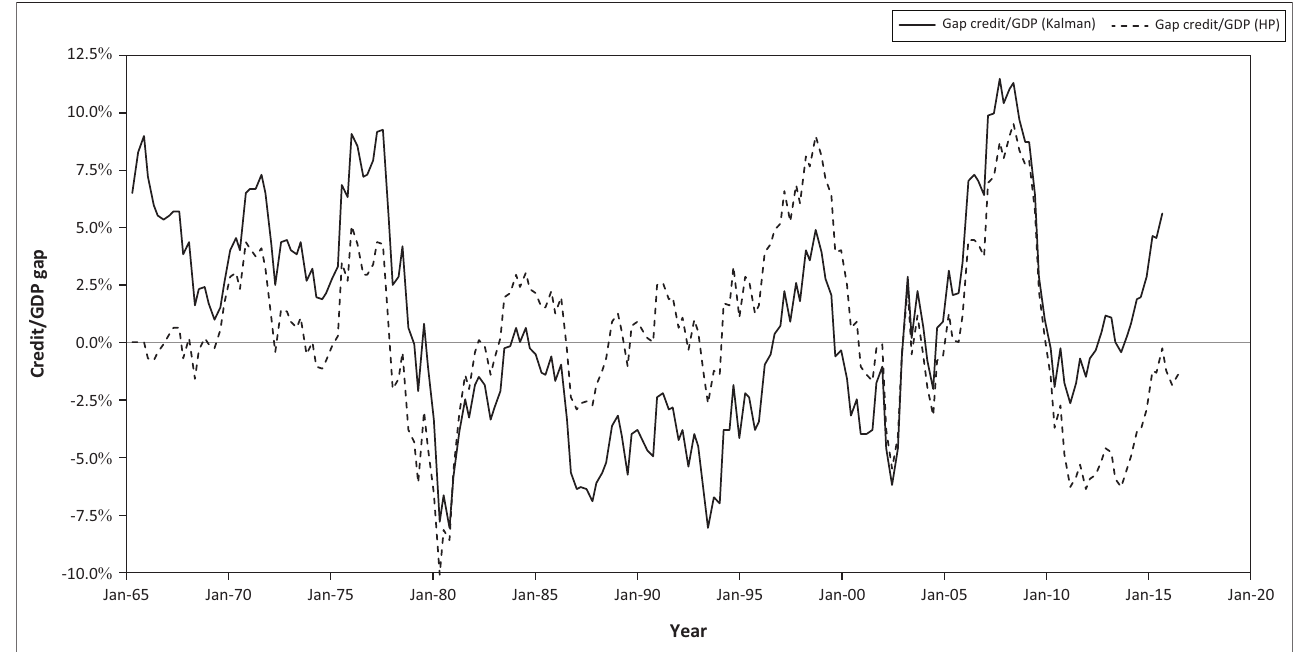
FIGURE 3: South African credit-to-GDP gaps using the Hodrick–Prescott ( λ = 144 000) and Kalman filters.